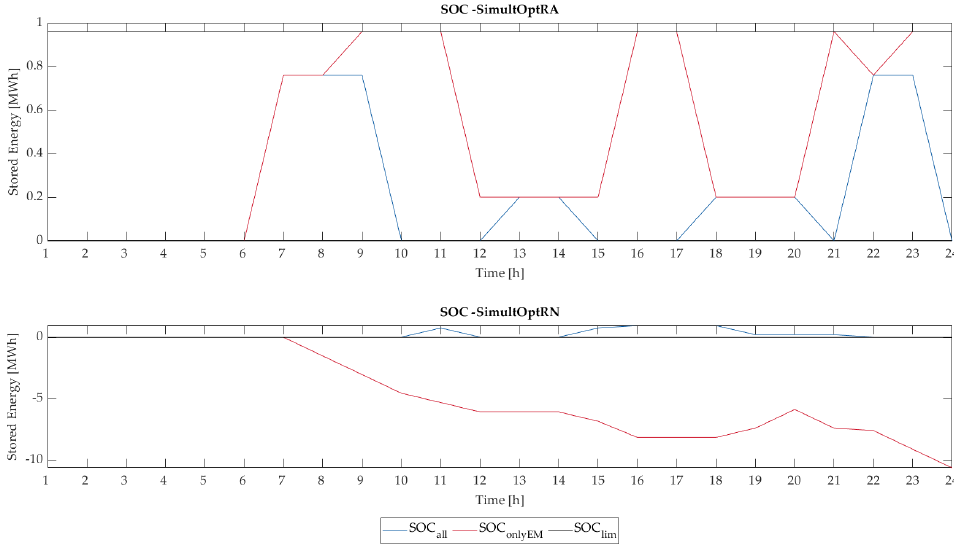
Figure 11. Comparison of theoretical SOCs when considering all flexibility activation SOC all and only considering electricity market schedules SOC onlyEM